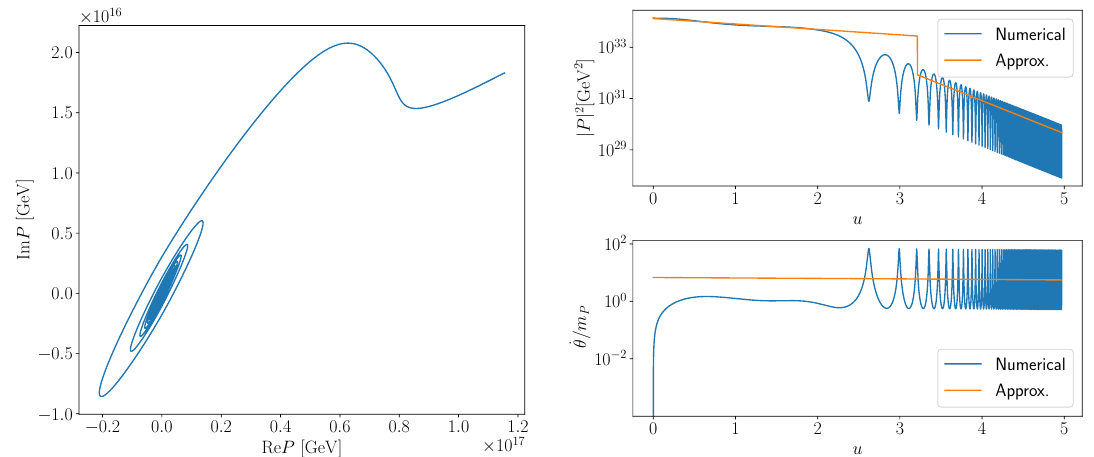
Figure 1 . The dynamics of the PQ field when the parameters are given by θ i = π/ 20 , T i = 10 13 GeV, v = 10 8 GeV and m = 10 6 GeV. The left panel is the plot on (Re P, Im P ) plane. The P P upper (lower) right panel shows | P | 2 ( ˙ θ/m ). The blue lines are the numerical solution, and the P yellow lines are the approximate